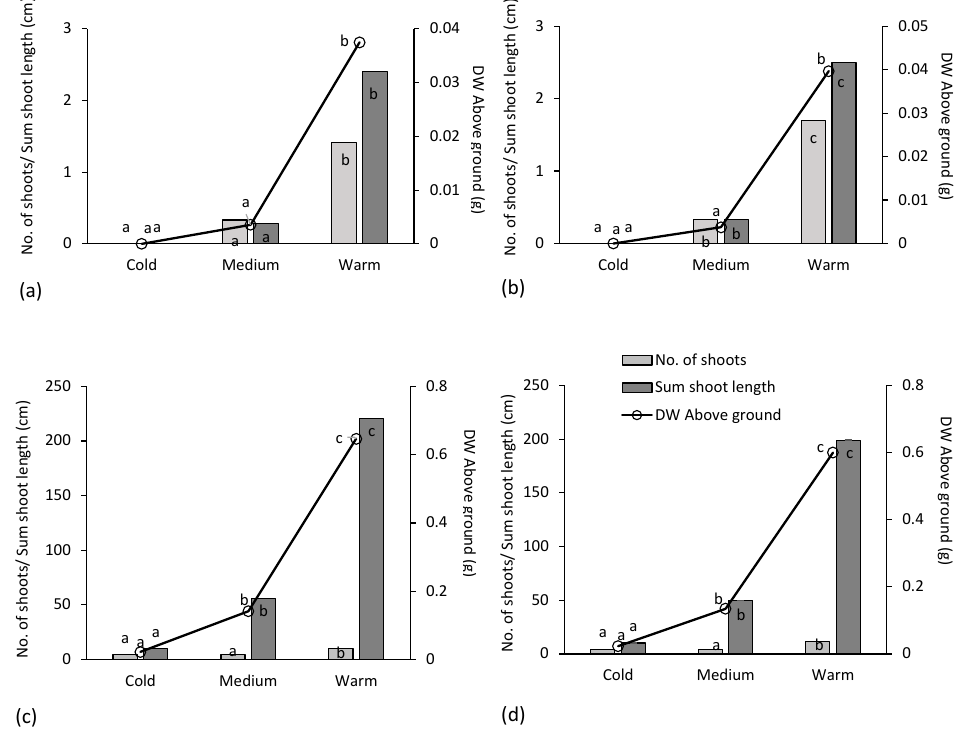
Figure 1. Effect of the temperature in growth chambers (see text) after 6 weeks on number of shoots, total shoot length and DW Above-ground of C. arvense and E. repens : ( a ) Averages for old and young plants of C. arvense previously at field control in the “Plant Age” experiment, ( b ) averages for five climate change treatments of young plants of C. arvense in the “Climate Change” experiment, ( c ) averages for old and young plants of E. repens previously at field control in the “Plant age” experiment, and ( d ) averages for five climate change treatments of young plants of E. repens in the “Climate Change” experiment. For C. arvense , the values are original (number of shoots, DW Above- ground) or back-transformed from ln(x + 1) (sum shoot length). For E. repens , the values are original (number of shoots) or back-transformed from ln(x + 1) (sum of shoot lengths, DW Above ground). Table 2. Number of shoots and total length of the shoots at 3 and 6 weeks in the growth chambers for C. arvense and E. repens , % of the values at 6 weeks (in bold) and absolute mean values with SE. Species Type of